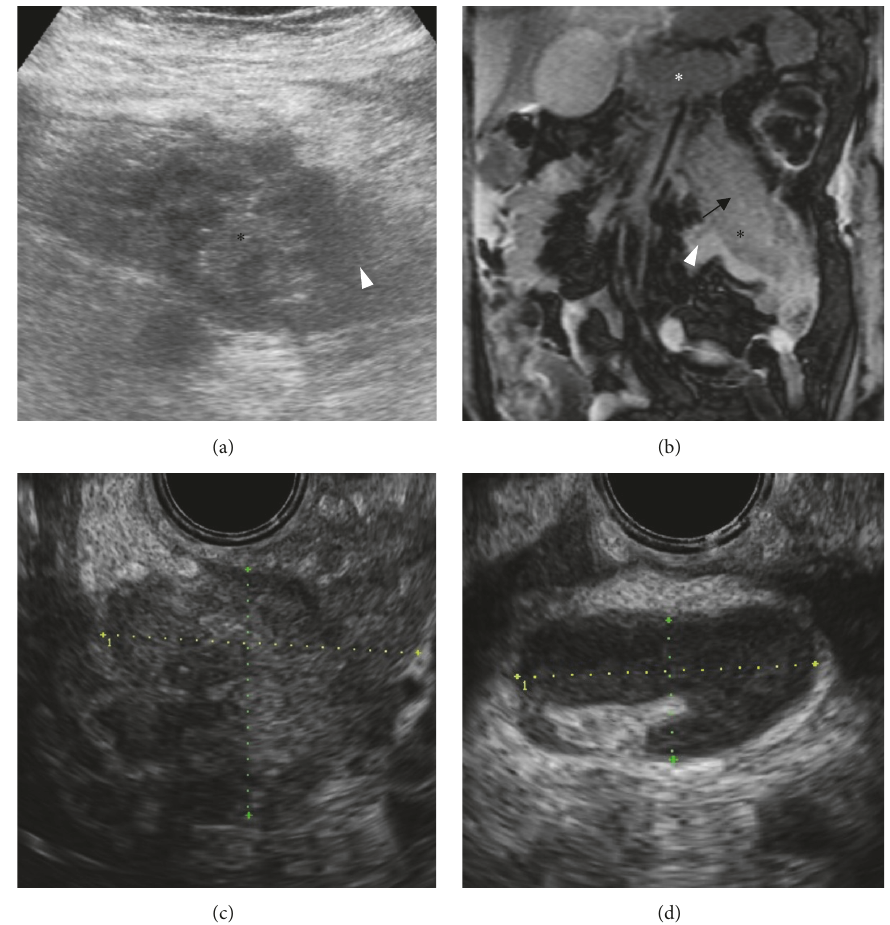
Figure2:(a)Ultrasoundimageofthemesentericsofttissuemass (black asterisks) withsurroundinginflammatorychanges (whitearrowhead) . (b) Coronal TRUFI image depicting the soft tissue mass with signal characteristics according to the orthotopic pancreas (white asterisk) . Surrounding, edematous inflammatory changes (white arrowhead) and a possible central duct (black arrow) . (c) EUS image of the hypoechoic mesenteric soft tissue mass, in the transversal plane measuring approximately 3 × 4cm. (d). EUS image of an enlarged mesenteric lymph node, with a short axis of 9 mm, demonstrating no suspicious morphological